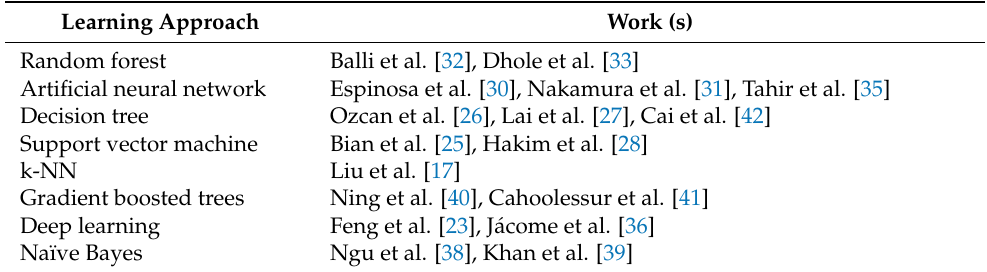
Table 2. Summary of recent works in fall detection that used different kinds of machine learning